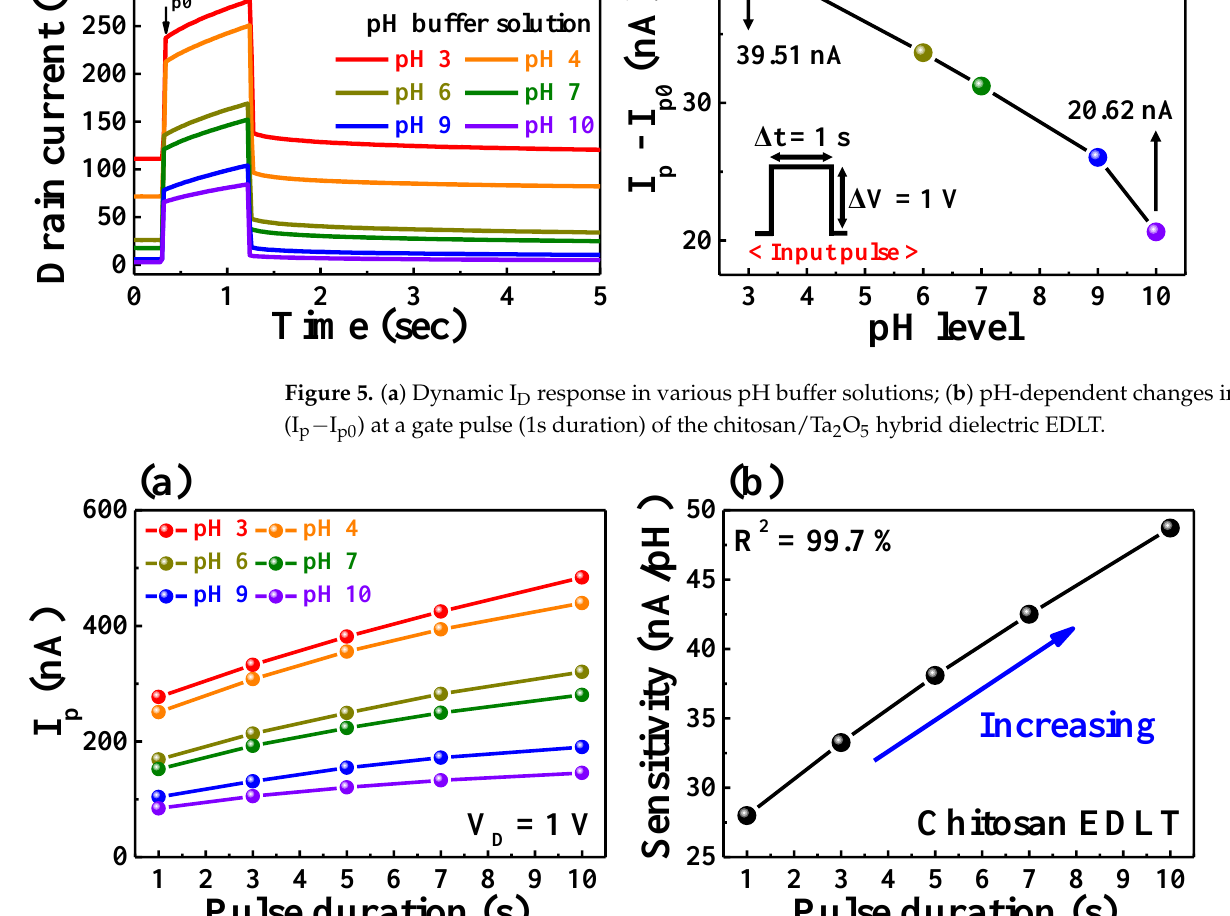
Figure 6. ( a ) Modulation of I p for a gate pulse and ( b ) pH sensitivity as a function of the pulse duration of the chitosan/Ta 2 O 5 hybrid dielectric EDLT in various pH buffers.